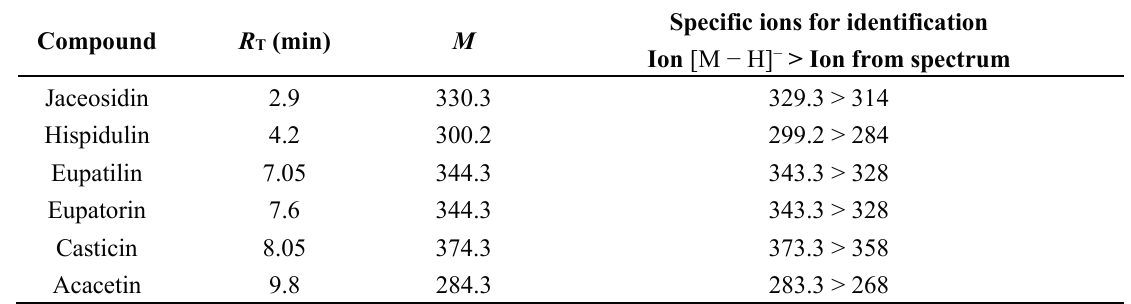
Table 2. Characteristic ions of standard sterols in full scan and specific ions used in quantification.